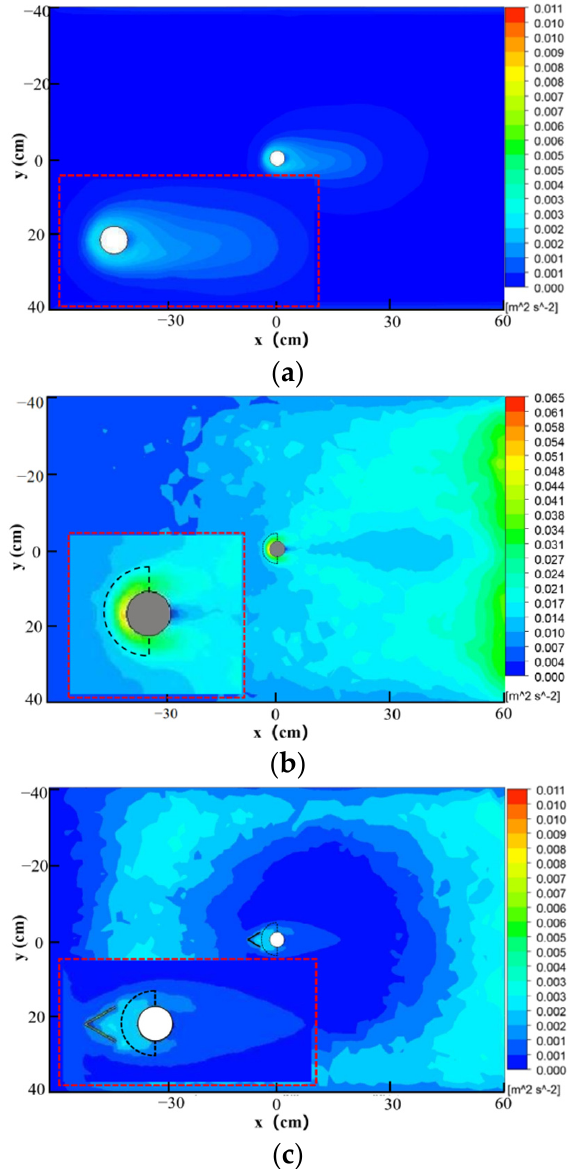
Figure 13. Turbulence kinetic energy at Z = 5 cm. ( a )Single pier; ( b ) Pier with ring-wing plate; ( c ) Pier with combined